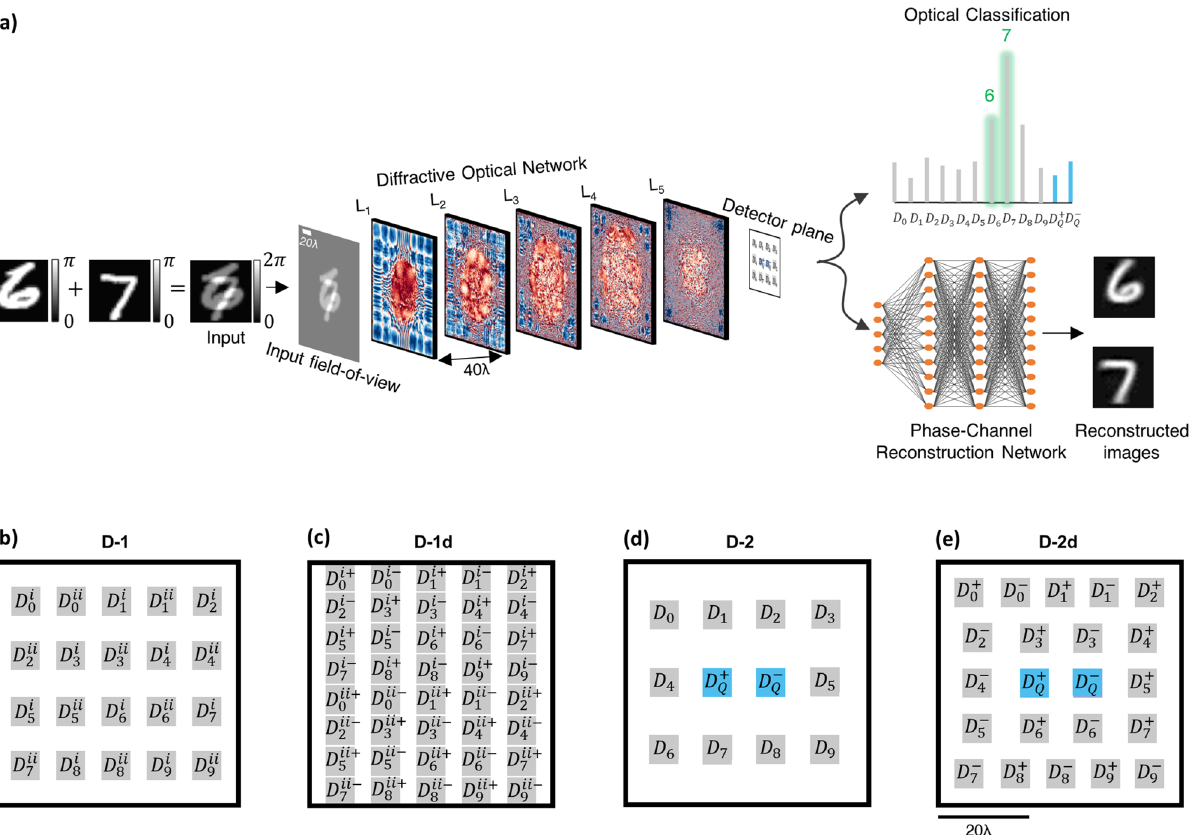
Figure 1. Schematic of a diffractive optical network that can all-optically classify overlapping phase objects despite phase ambiguity at the input; this diffractive optical network also compresses the input spatial information at its output plane for simultaneous reconstruction of the individual phase images of the overlapping input objects using a back-end electronic neural network. ( a ) Optical layout of the presented 5-layer diffractive optical networks that can all-optically classify overlapping phase objects, e.g., phase-encoded handwritten digits, despite the phase ambiguity at the input plane due to spatial overlap. The diffractive